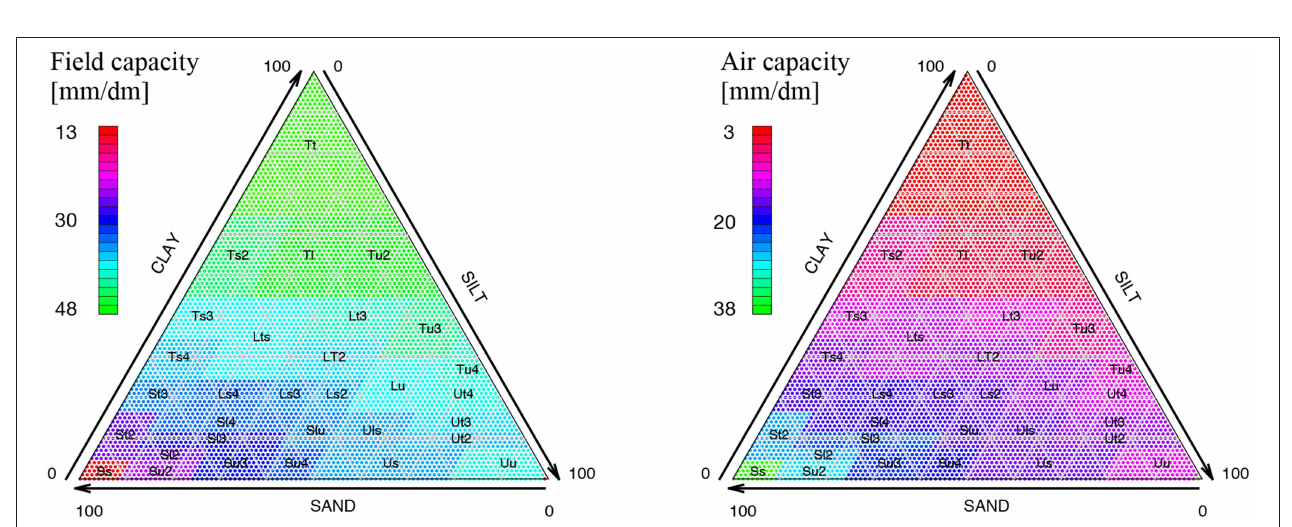
FIGURE 4 | Field capacity (Left) and air capacity (Right) as derived from soil textural classes according to the German soil classification (Ad-hoc-Arbeitsgruppe Boden, 2005). The range of values from low (red) to high (green) assuming a bulk density of 1.3 g/cm 3 is given in